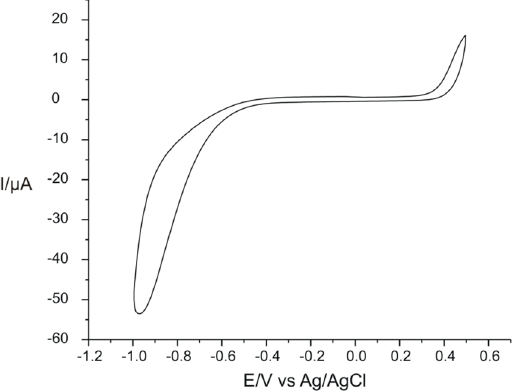
Figure 4. The electrochemical behavior of the unmodified sensor in a double solution of 0.1 M KCl and 10 − 3 M L-TRP at a scan rate of 0.1 V × s − 1